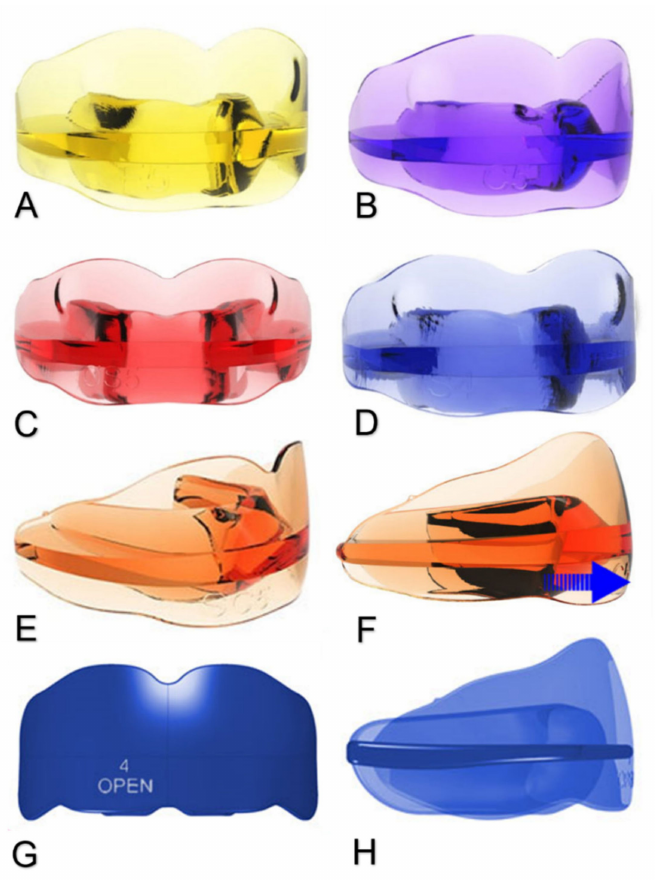
Figure 1. ( A – H )—AMCOP ® Integral, the different types of which are identified by a color and a corresponding letter: yellow F ( A ); purple C ( B ); red OS ( C ); blue S ( D ); AMCOP ® SC with its unique orange color ( E ) showing the mandibular movement ( F ); and AMCOP ® Open ( G , H ) (source: www.amcop.info, accessed on 20 March